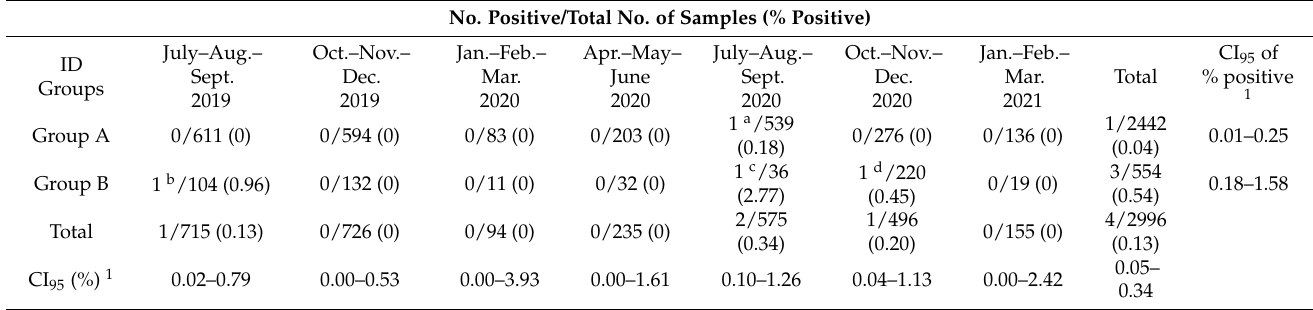
Table 3. Listeria monocytogenes in ready-to-eat foods, from July 2019 to March 2021. No. Positive/Total No. of Samples (%